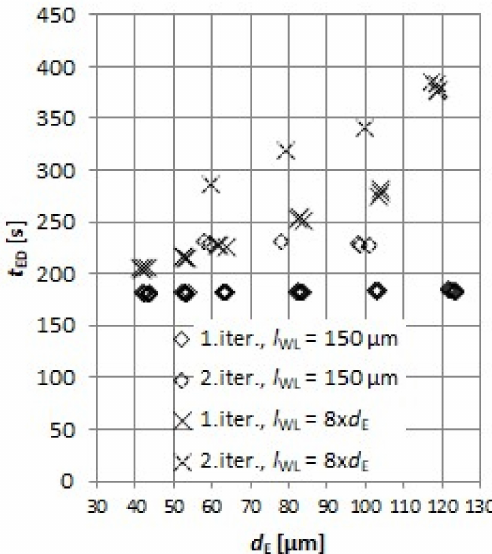
Figure 8. Electrode dressing times t ED for various electrode diameters d E and electrode working lengths l WL